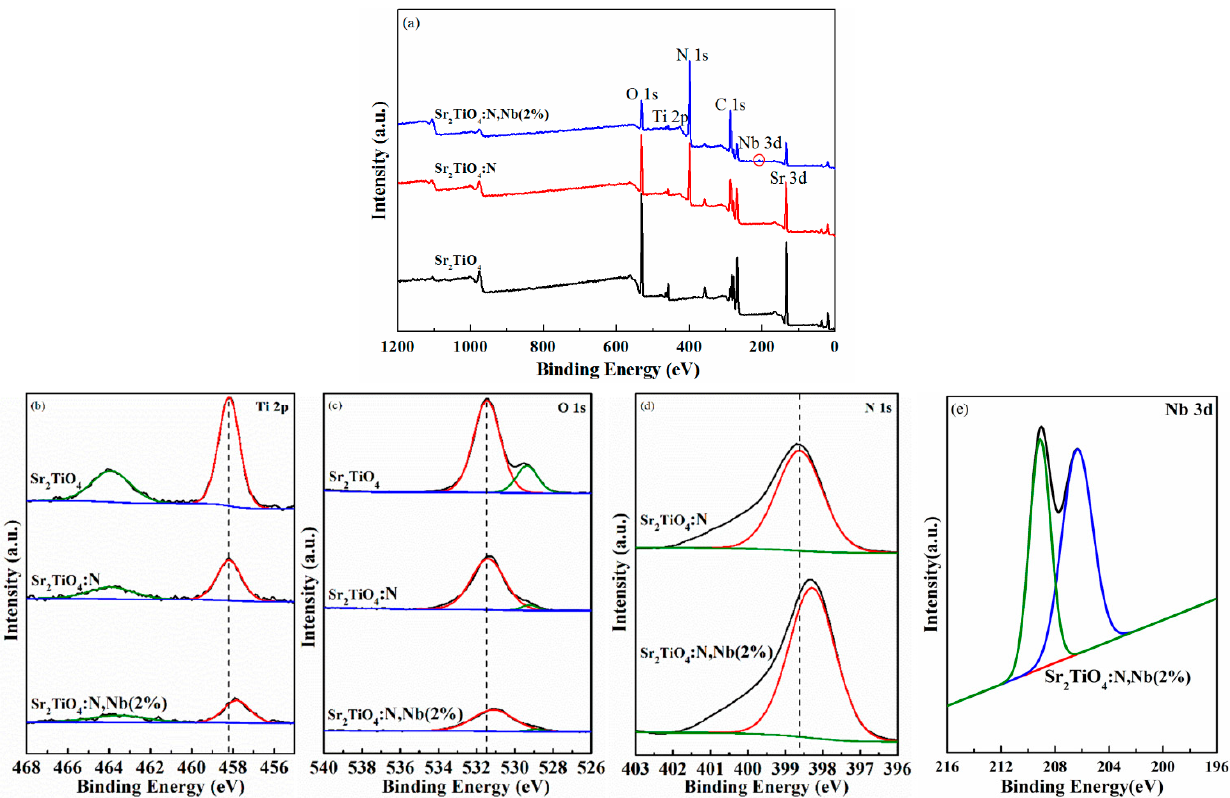
Figure 5. XPS spectra of the pristine and doped Sr 2 TiO 4 : ( a ) full survey spectra, the peak circled in red belongs to Nb 3d; ( b ) Ti 2p; ( c ) O 1s; ( d ) N 1s; ( e ) Nb 3d. The charge carrier behaviors of the pristine Sr 2 TiO 4 and Sr 2 TiO 4 :N,Nb with different